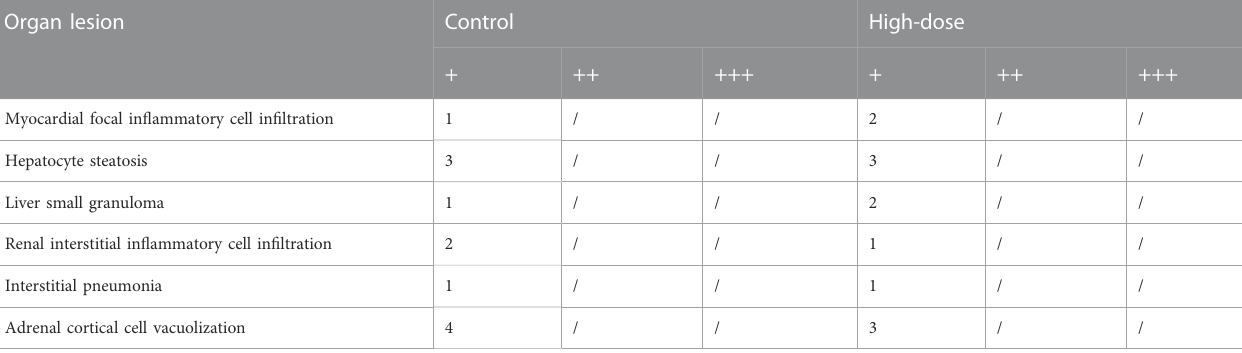
TABLE 5 Histopathological fi ndings of rats after 28 days of administration with GCXXD ( n = 10). Organ